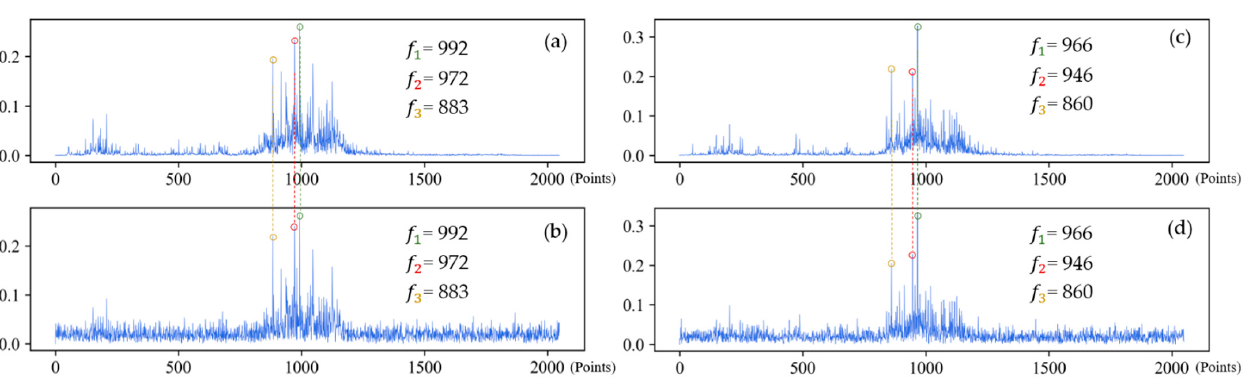
Figure 18. The frequency spectrums of IRF-0.021 under different working conditions. First three feature frequencies are noted in each frequency spectrum. ( a ) Frequency spectrum of original signal under 1 hp; ( b ) Frequency spectrum of noisy signal under 1 hp (SNR = 0 dB); ( c ) Frequency spectrum of original signal under 3 hp; ( d ) Frequency spectrum of noisy signal under 3 hp (SNR = 0 dB).